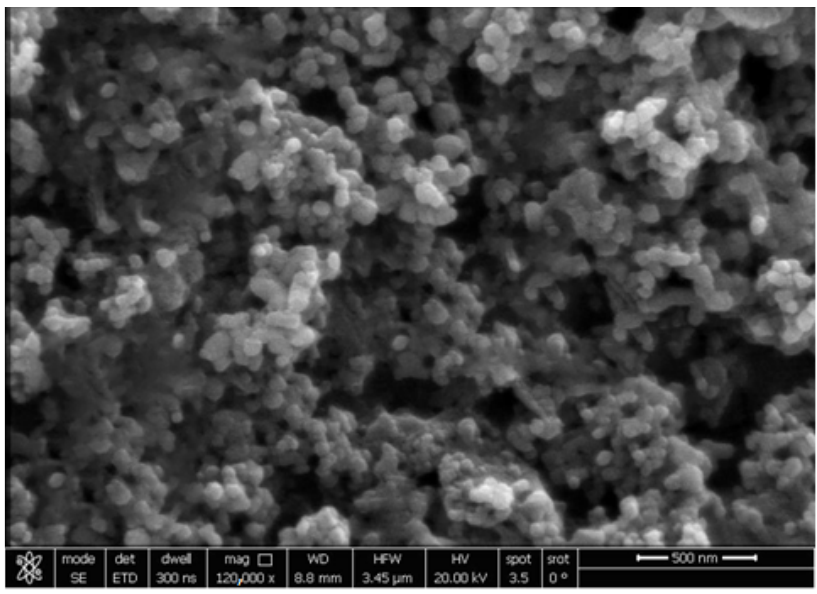
Figure 4. SEM image of silver nanoparticles.